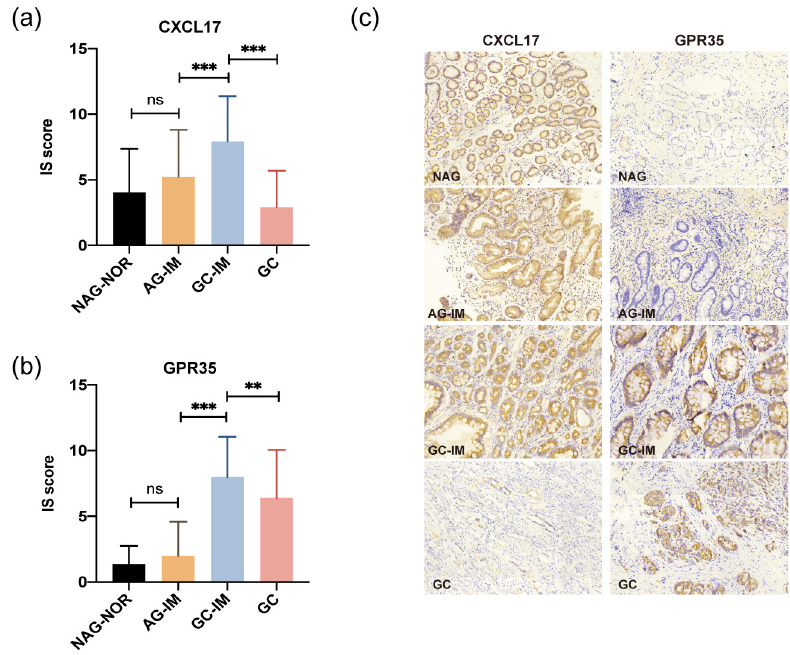
Figure 1. The protein expression of CXCL17 ( a ) and GPR35 ( b ) in different pathological lesions determined by immunohistochemistry. ** p < 0.01, *** p < 0.001. ( c ) Representative immunostaining images of CXCL17 and GPR35 in different gastric pathological lesions. Magnification: × 200. ns, no significance; NAG-NOR, normal gastric gland of non-atrophic gastritis; AG-IM, intestinal metaplasia of atrophic gastritis, GC-IM, intestinal metaplasia adjacent to gastric cancer; GC, gastric cancer.